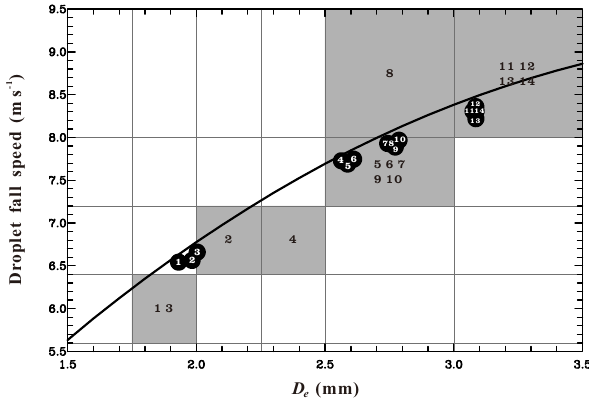
Figure 8. Size and velocity distribution of 14 water drops that were observed simultaneously by both HSC and PARSIVEL. Each drop is distinguished with labeled digits from 1 to 14. HSC-observed ve- locities (sizes) are indicated by solid black circles with white digits and the PARSIVEL measurements are indicated by shading with black digits. The theoretical curve of V t is also superposed on the analysis